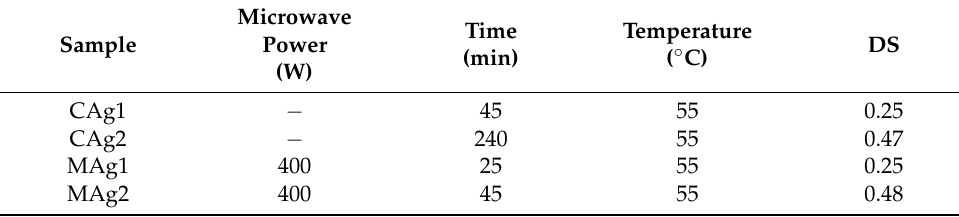
Table 6. Synthetic conditions for carboxymethyl agar with similar DS